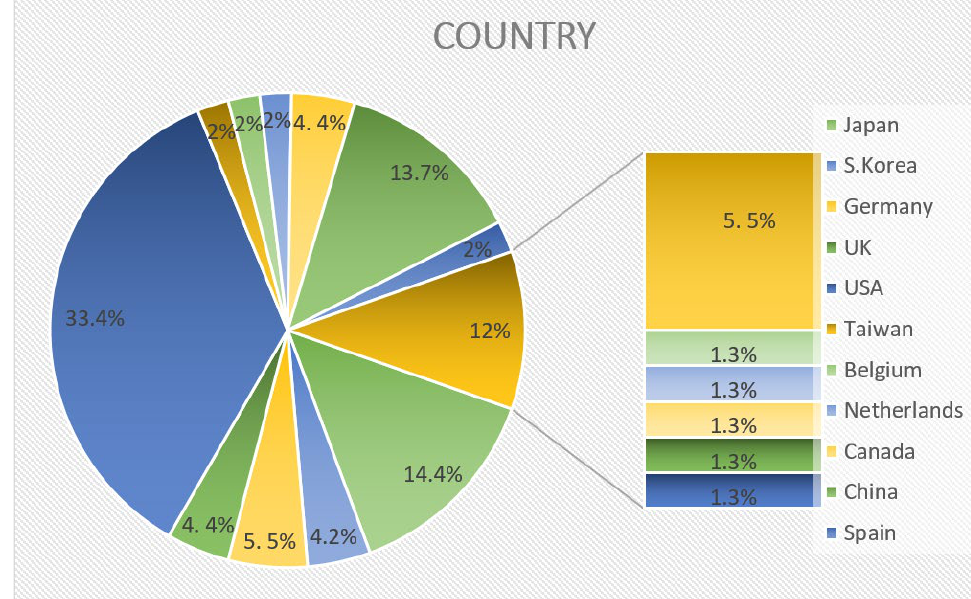
Figure 11. Classification based on geographical position of companies participating in ASSB activi- ties.